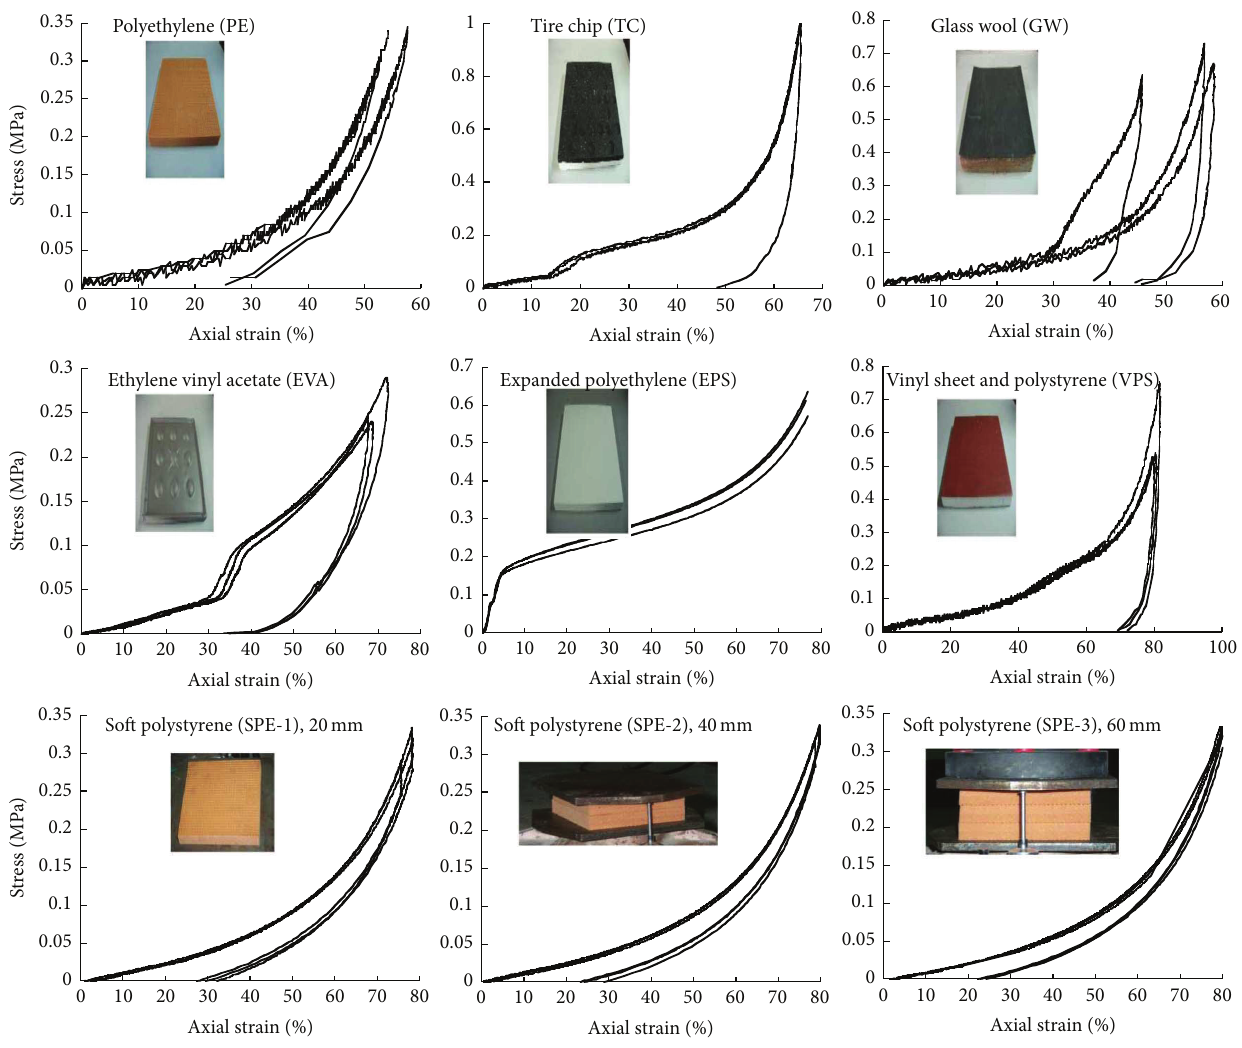
Figure 2: Stress versus strain curves of resilient